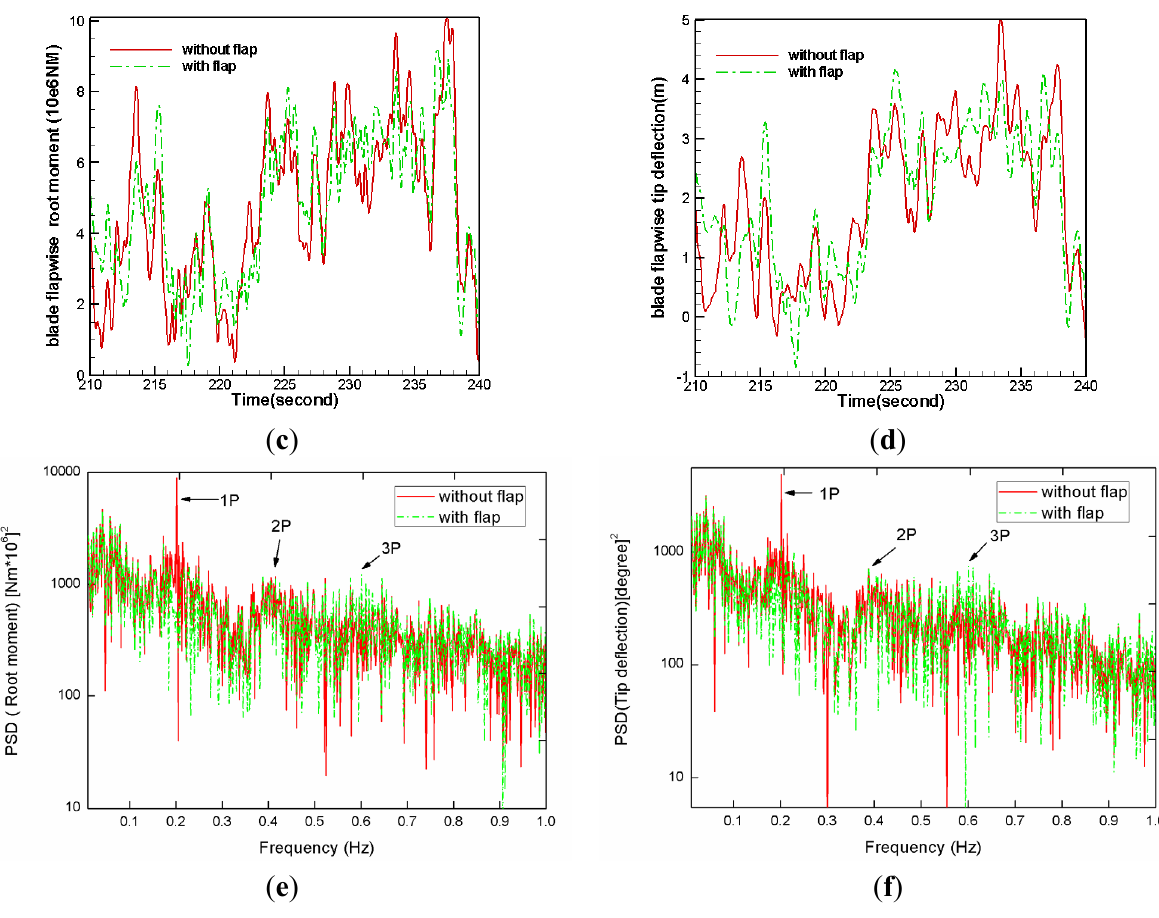
Table 5. Std of M